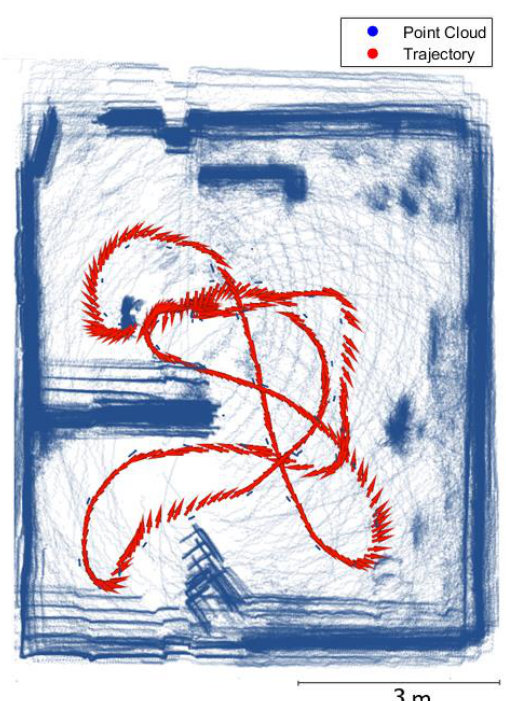
Figure 5. Top view of the MAX Grape map (3D point cloud) and trajectory in the Berrozi